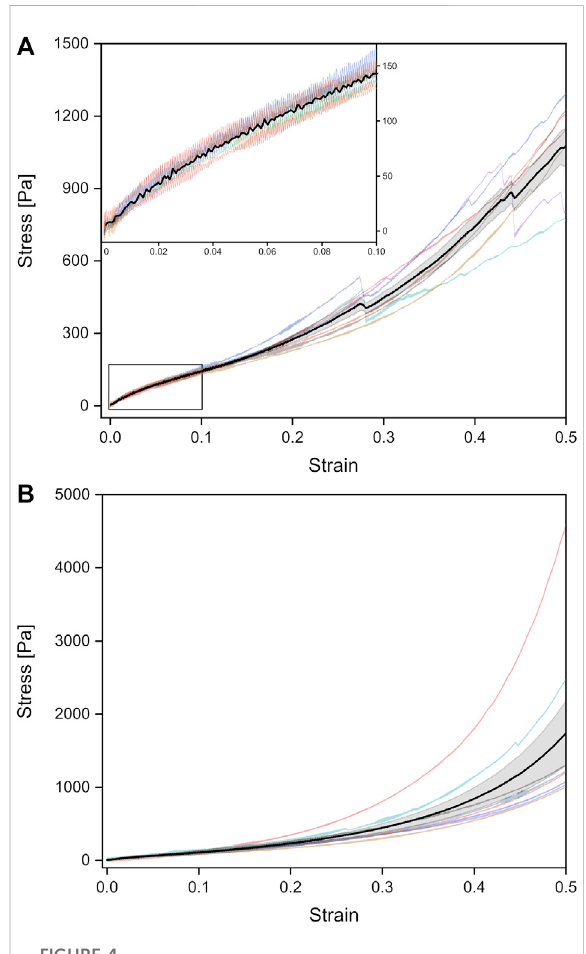
FIGURE 4 Stress-strain curves of unrinsed ( viz. surfactant-containing) adult rat lungs tissue samples under tension (A) and compression (B) , obtained from a probing velocity of 7 mm · min − 1 . The black curves represent the mean values with the standard error obtained from all individual tests shown in different